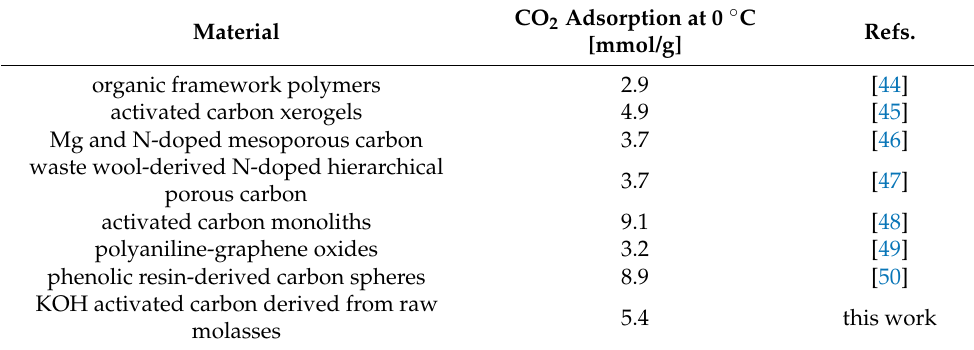
Table 2. Langmuir CO 2 adsorption of various activated carbons at 1 bar and 0 ◦